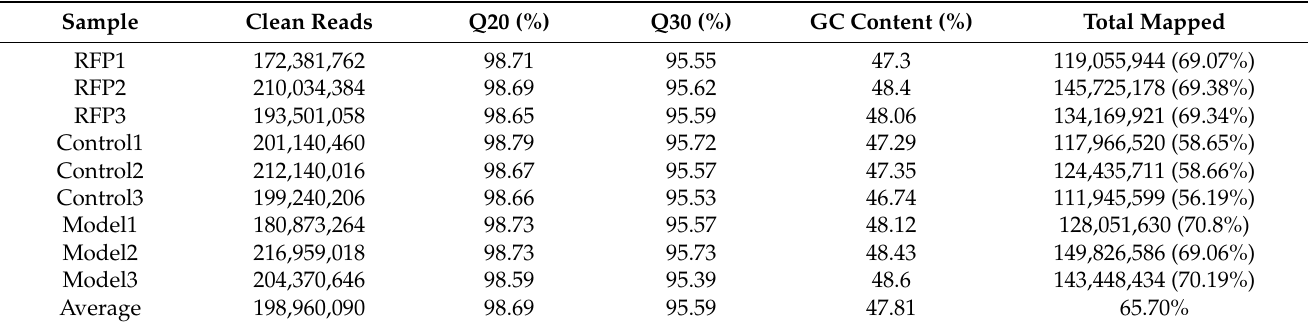
Table A1. Summary of RNA − seq data assessment.